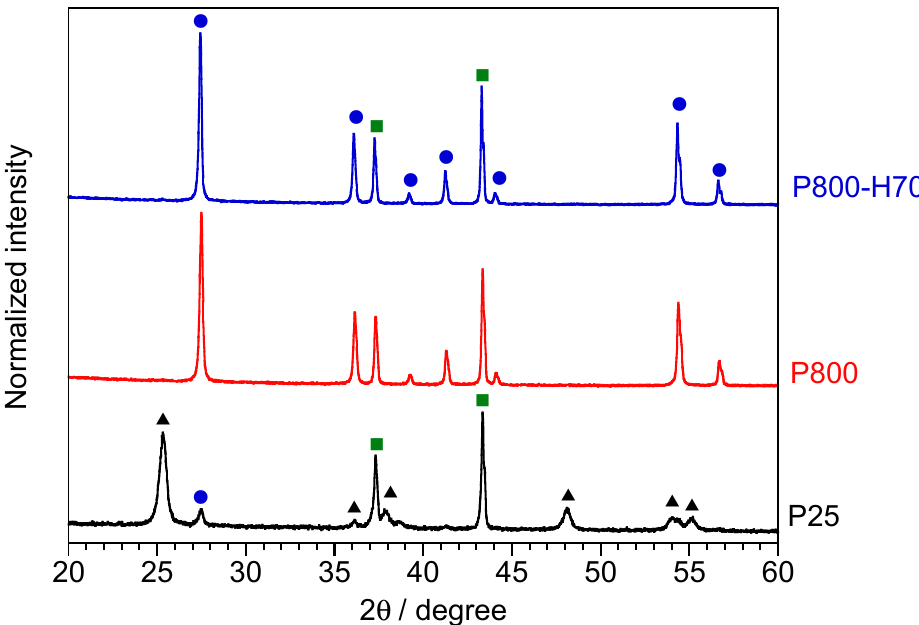
and rutile (13%) [24,29]. Calcination at 800 °C converted anatase to pure rutile (100%). P800-H700 also consisted of a single phase of rutile TiO 2 .